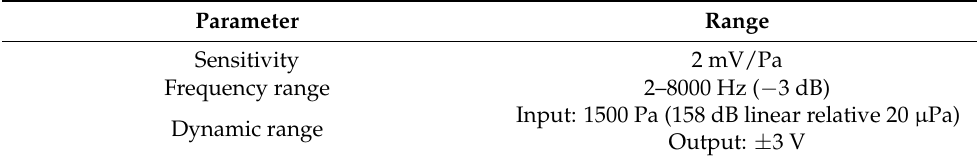
Table 2. Technical specification of